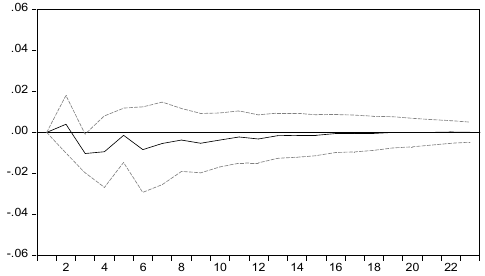
Figure 1. Response of NASSEP to CONFI CONFI in this period, the early stage will have a positive effect on ERATE , but this positive effect will continue to weaken over time, then gradually converge to zero, and finally the effect disappears. The exchange rate of this article adopts the direct price method, and the positive reaction represents the rise of the dollar against the Renminbi, that is, the devaluation of the Renminbi. After the trade war, China’s exports to the United States fell sharply in the short term, the trade surplus with the United States decreased, and the growth rate of foreign exchange reserves declined, which in turn affected the foreign exchange market, forcing the yuan to depreciate. The devaluation of the Renminbi triggered an automatic adjustment mechanism that played a role in China's exports and entered a new balance.